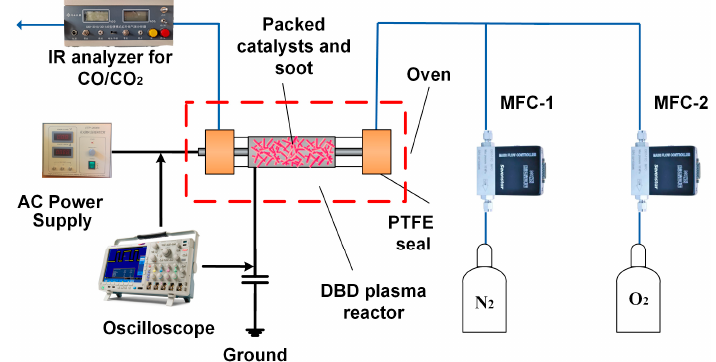
Figure 9. Experimental setup of plasma–catalytic soot